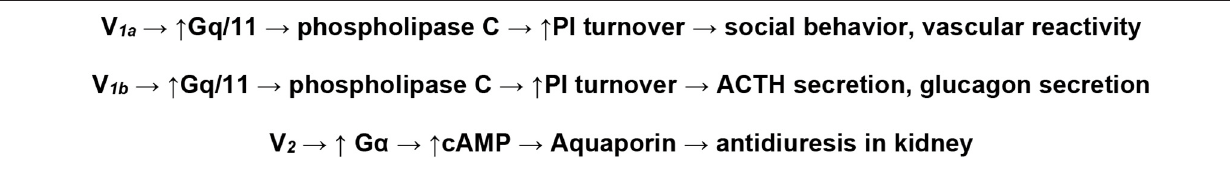
FIGURE 2 | There are three subtypes of the G-protein linked vasopressin receptors. V 1 a receptors are found on vascular smooth muscle and platelets and induce vasoconstriction through increased phosphatidyl inositol (PI) metabolism; V 2 receptors are found primarily in on principal cells of the kidney collecting ducts and mediate water reabsorption through aquaporins stimulated by AVP in the systemic circulation; V 1 b receptors are found primarily in cells of the pituitary, white adipose tissue, and the pancreas. AVP secreted from parvocellular neurons and flowing through the hypophyseal portal circulation stimulates pituitary adrenocorticotropic hormone (ACTH) secretion through interaction with V 1b receptors in pituitary corticotrophs by potentiating the stimulatory effects of corticotrophin-releasing hormone on